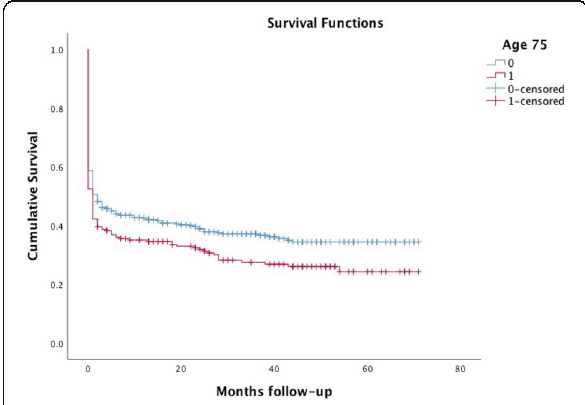
Fig. 1 (abstract 000795). Kaplan-Meier survival Blue line <75 years age Red ≥ 75 Log-rank P=0.023